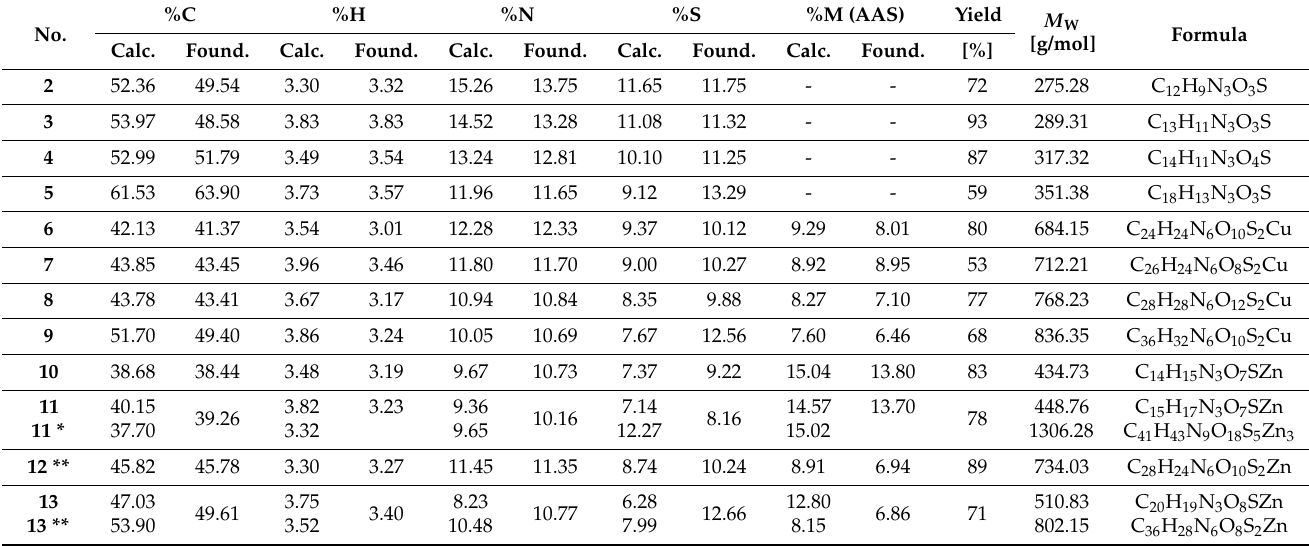
Table 1. Microanalysis (C,H,N,S), AAS, molecular weight, yields, and chemical formulae of coumarin-thiadiazole hybrids and their Cu(II) and Zn(II) complexes 2 – 13